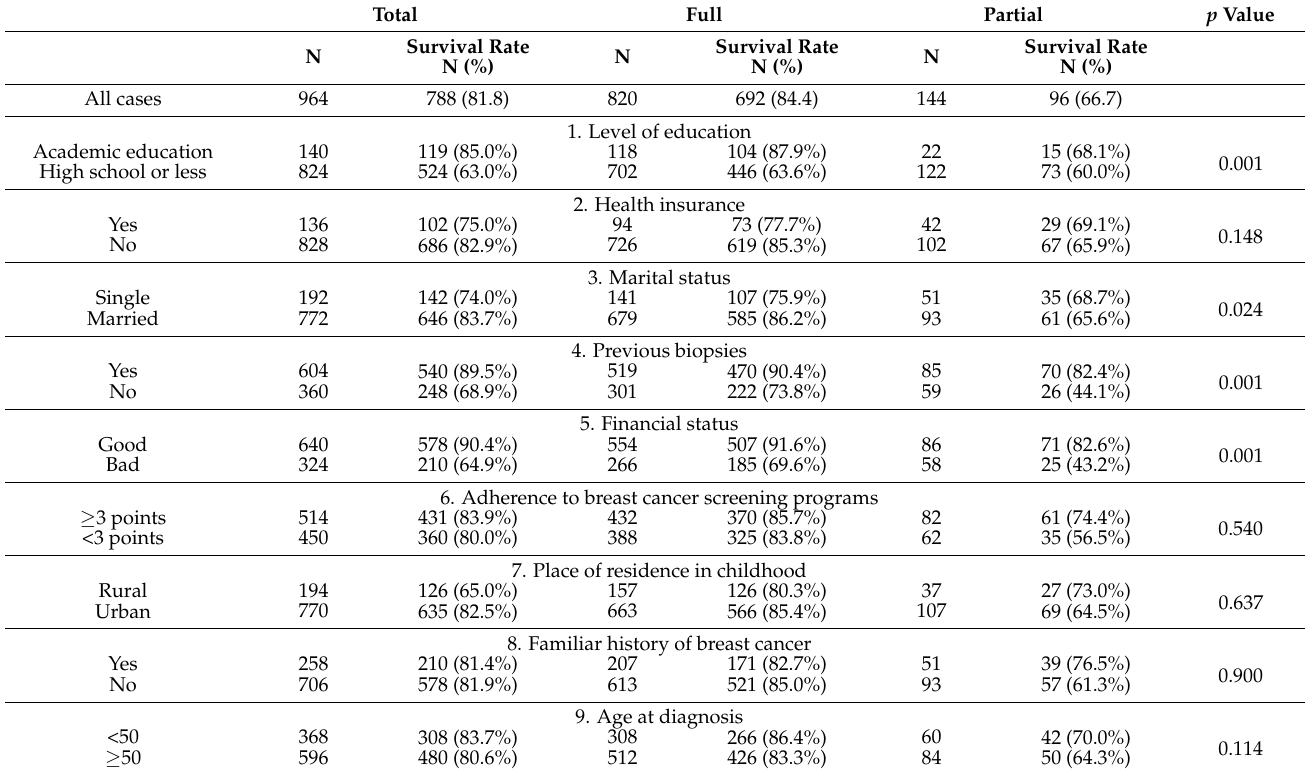
Table 1. Survival analysis stratified by the course of